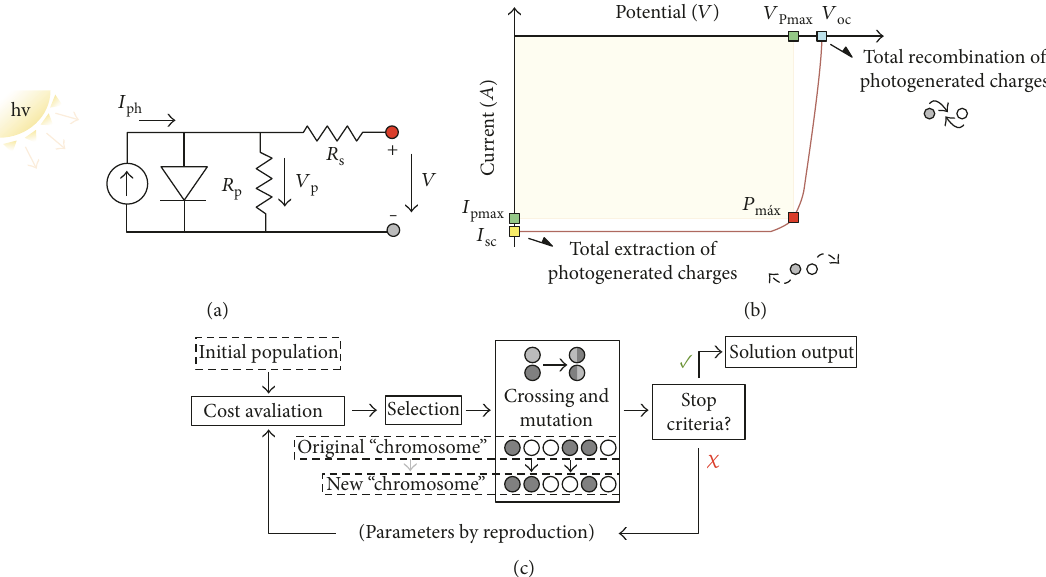
Figure 2: (a) Equivalent circuit used to modulate the organic solar cell parameters. (b) Typical current-voltage behavior of a solar cell and the relevant points to be considered in order to calculate all fi gures of merit and the e ffi ciency. The rectangle inside the I - V curve gives the fi ll factor as well as the maximum generated power. (c) Simple scheme of the genetic algorithm fl ow used for the simulations.